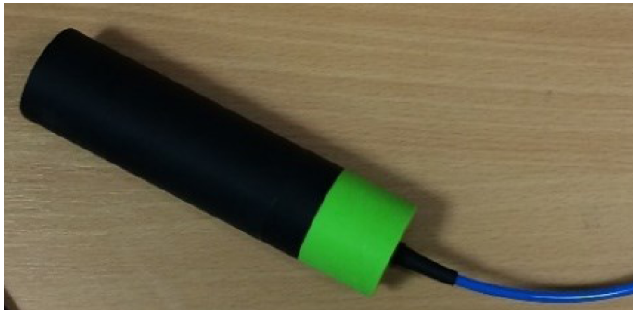
Figure 4. Execution of a membrane pressure sensor.